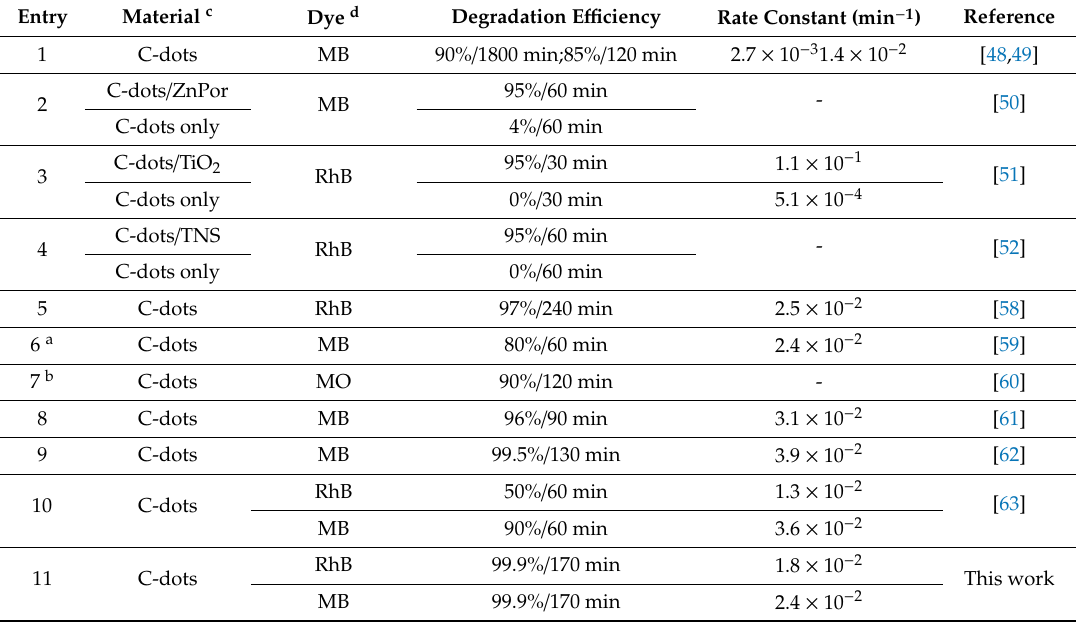
Table 1. Comparison of the photo degradation performance of di ff erent C-dots-related catalysts.